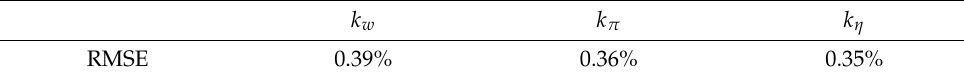
Table 1. Test error of neural network offset coefficient estimation